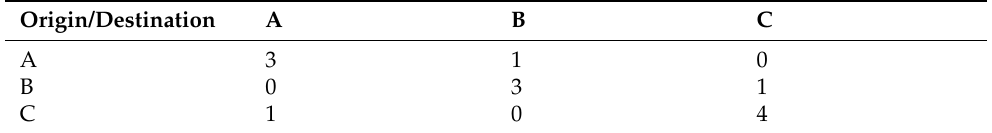
Table 2. Example demand matrix.